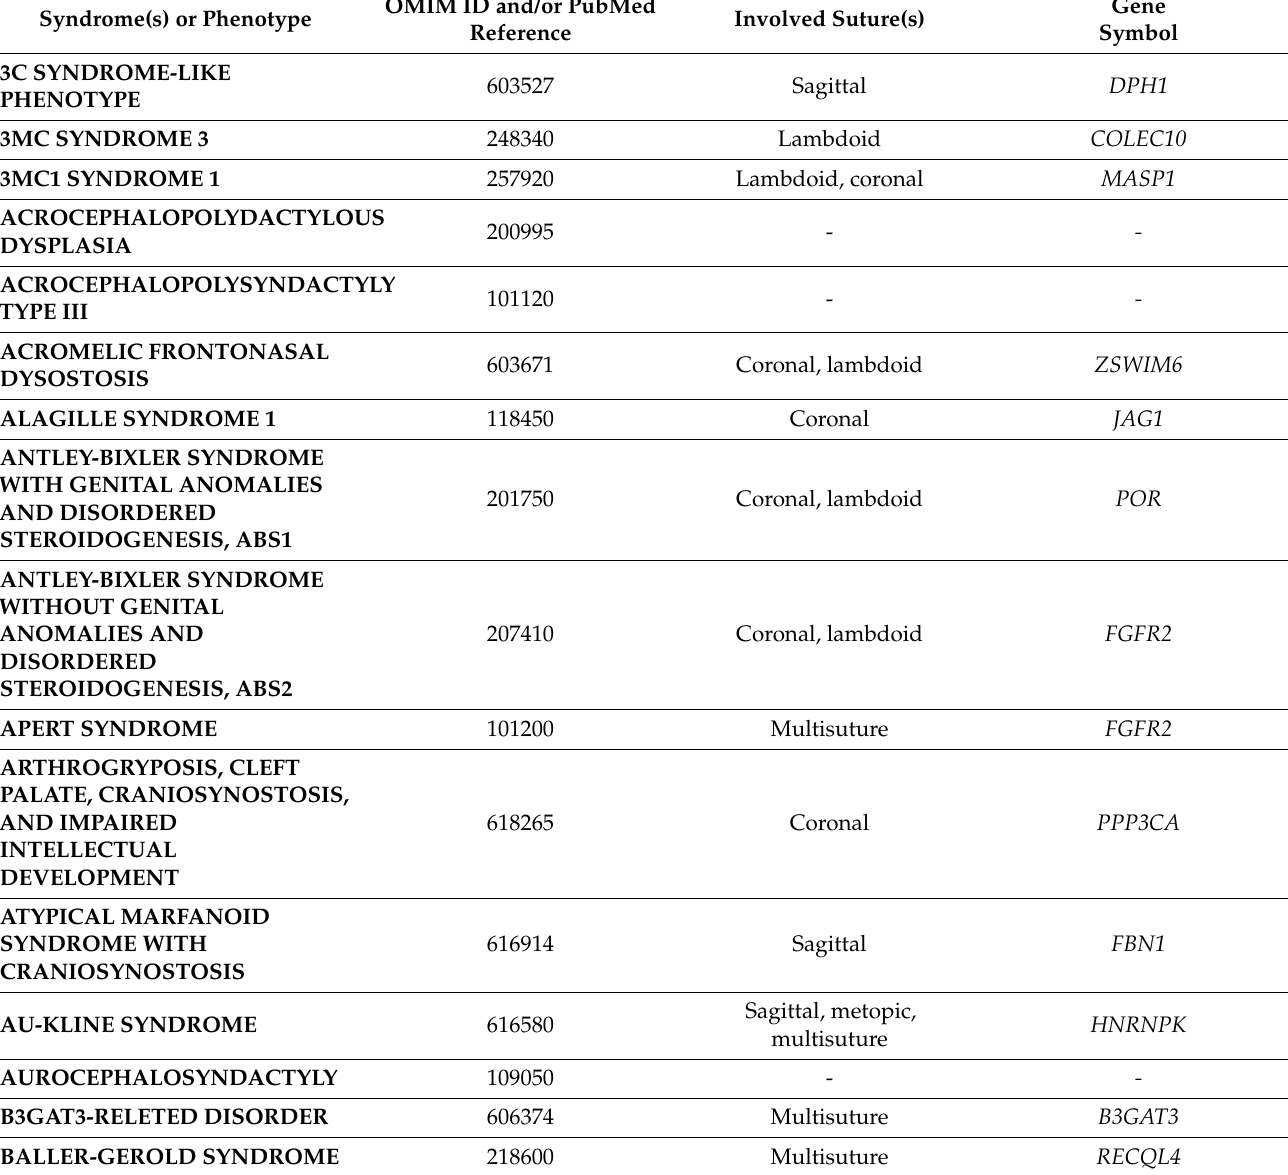
Table 1. Syndromic craniosynostosis and associated